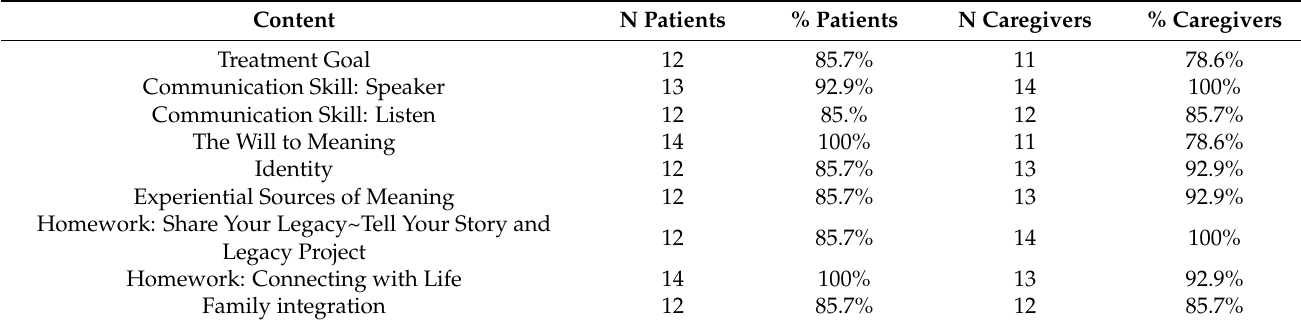
Table 2. Descriptive statistics for the acceptance